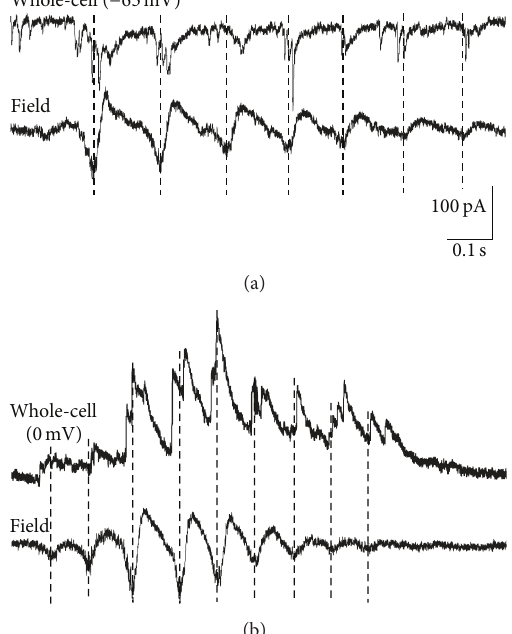
Figure 6: Synaptic events underlying a spindle burst recorded in S1 of a P6 rat in vivo. (a) Simultaneous registration of membrane currents (upper trace) and local field potential (lower trace). In this recording the membrane potential was held at − 65mV to isolate glutamatergic postsynaptic currents (PSCs). Note that the gluta- matergic PSCs are phase locked to the field potential oscillations. (b) Recording at a holding potential of 0mV to isolate GABAergic PSCs. Note that GABAergic PSCs are also phase locked to the field potential oscillations. Reproduced with permission from